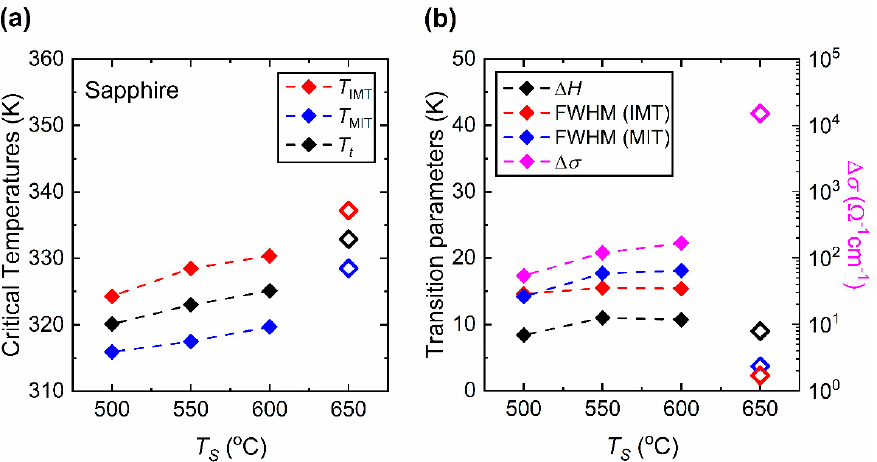
Figure 11. Electrical conductivity phase transition properties of VO 2 films prepared on sapphire substrates at various substrate temperatures ( T S ). ( a ) Critical temperatures of the phase transition ( T IMT , T MIT and T t ). ( b ) Phase transition parameters ( Δ H , FWHM (IMT), and FWHM (MIT)) and the contrast of conductivity, Δ σ = σ (368 K)/ σ (300 K). The data points for the substrate temperature 650 °C are from Ref. [32] and displayed in hollow symbols.